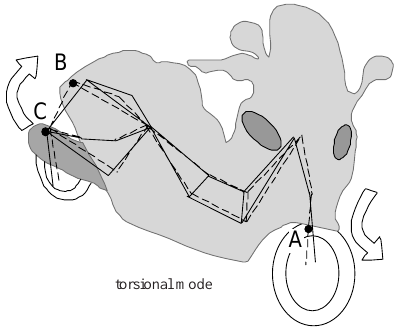
Fig. 13. Vehicle B, torsional mode, frequency 16.9 Hz, hysteretic damping 4.8%.